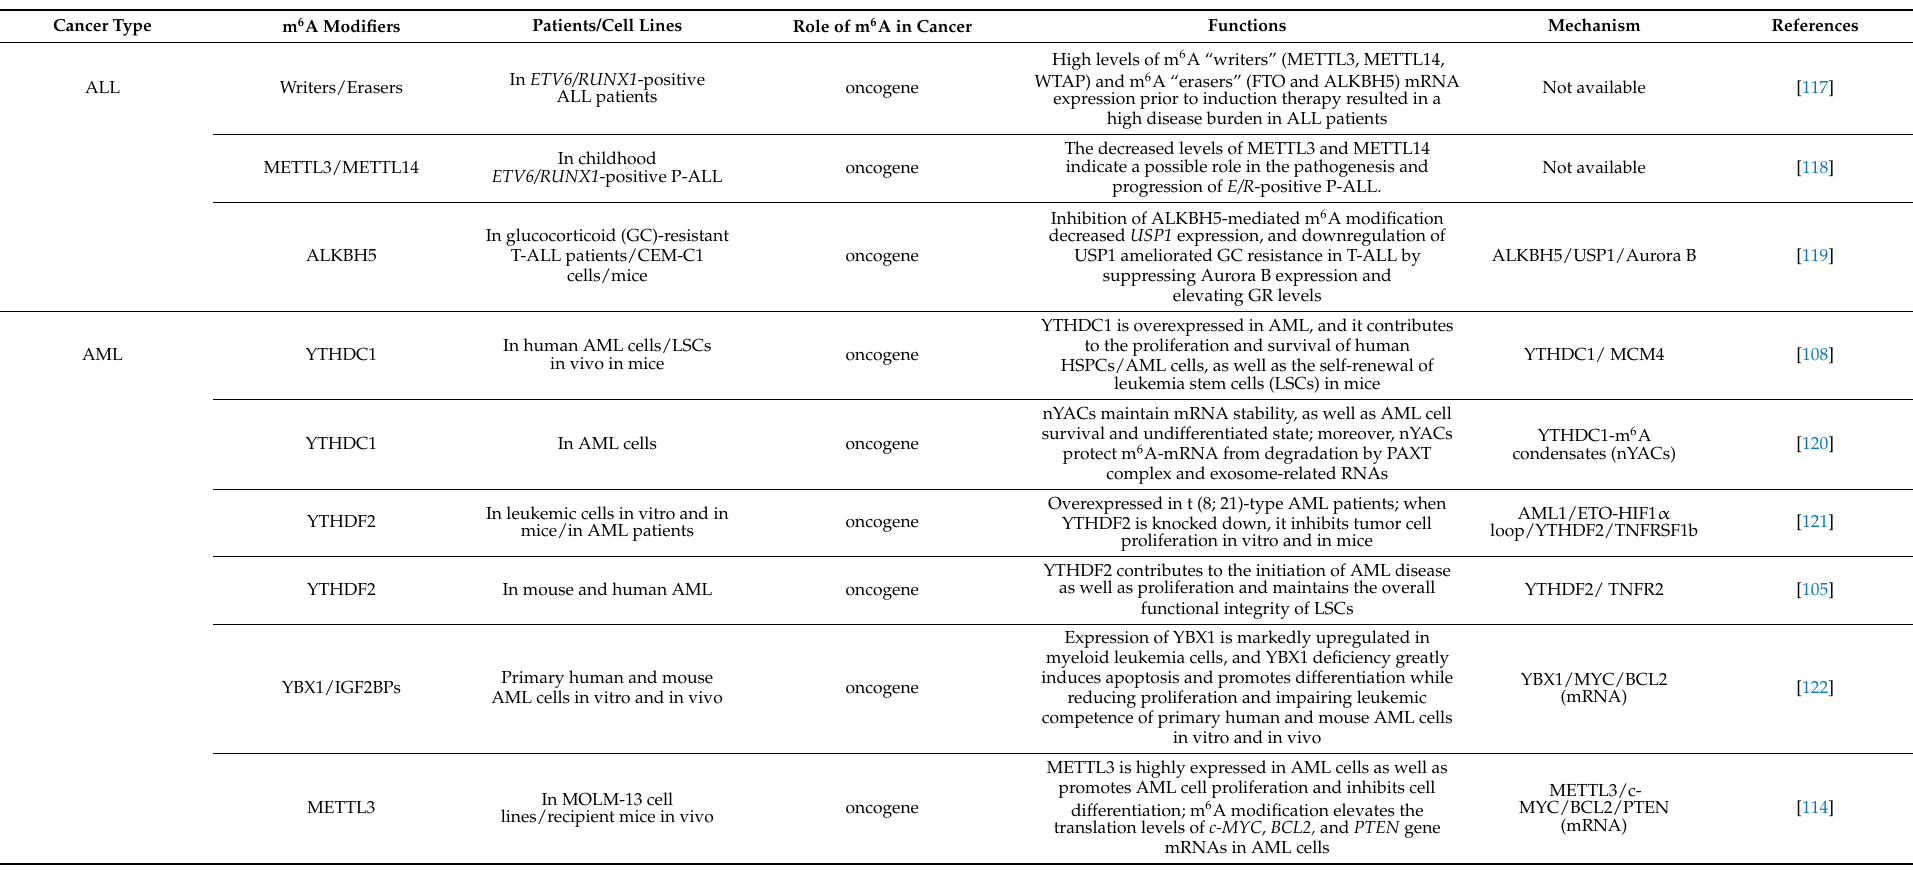
Table 1. The functional roles of RNA m 6 A methylation modification in various types of hematologic